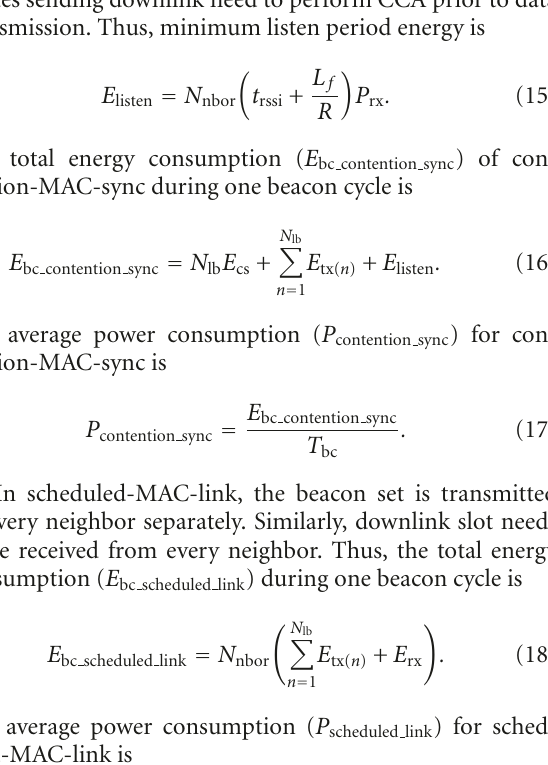
Figure 12: Location node beacon cycle using scheduled-MAC- node.